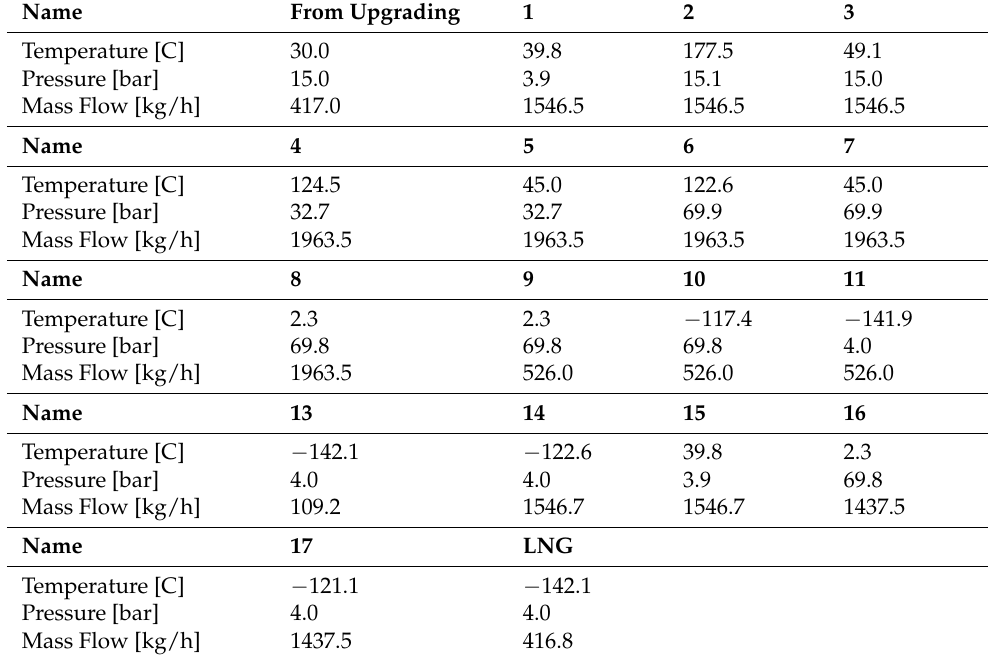
Table A1. States of the biomethane flows in the Base Case.